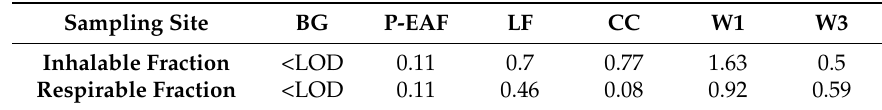
Table 3. Mass concentration (mg/m³) of the inhalable and respirable fractions measured in BG, P-EAF, LF, CC, W1 and W3 sampling locations.